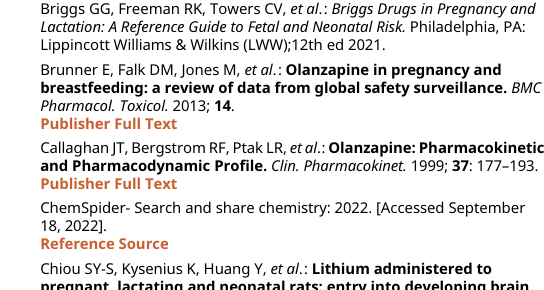
Figshare: ARRIVE checklist for ‘ Entry of the antipsychotic drug, olanzapine, into the developing rat brain in mono- and combination therapies ’ . https://doi.org/10.26188/c.6273693 (Huang et al. , 2022). Data are available under the terms of the Creative Commons Attribution 4.0 International license (CC-BY